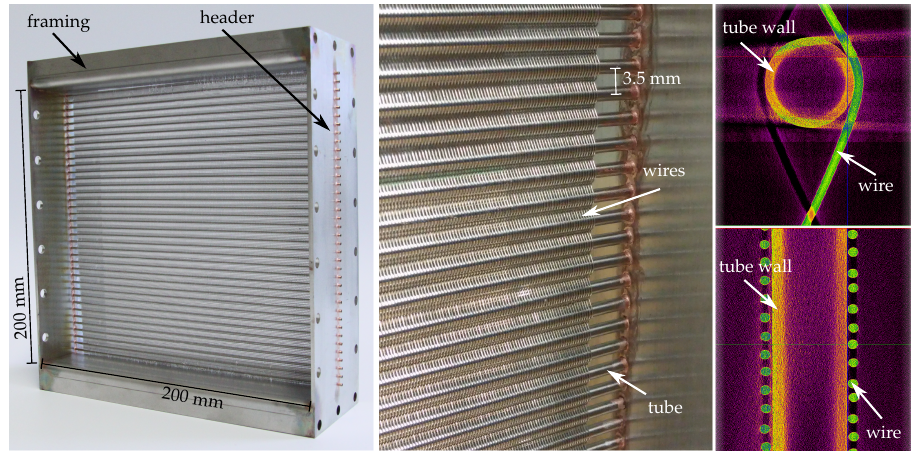
Figure 2. Wire cloth heat exchanger. Left: Heat exchanger with frame. Middle: Detail of the wire cloth and integration into the header/distributor plate. Right: Micro Computer Tomography views of the contact between wires and tube. Table 1. Validation of the uncoupled